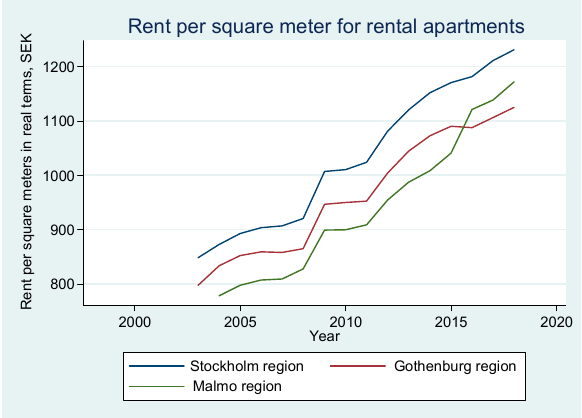
Figure 10. Rent for rental apartments in the three largest urban areas in Sweden.